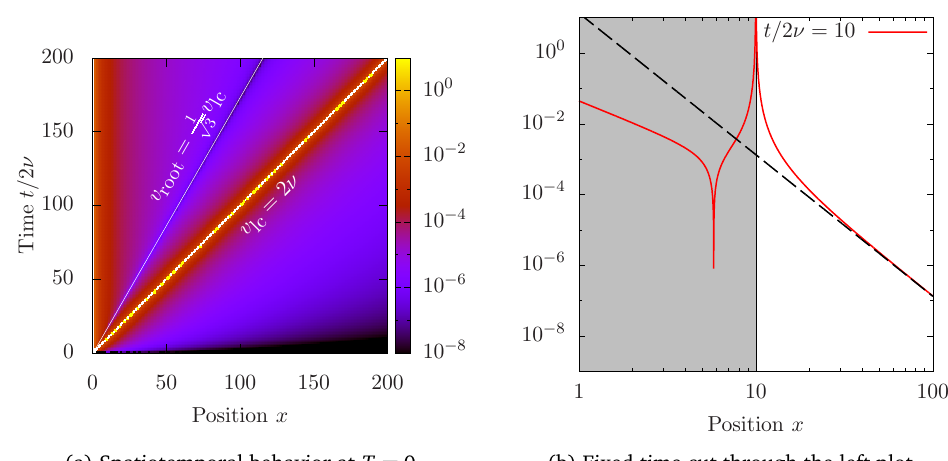
Figure 2: Spatiotemporal behavior of the equal-time anticommutator | C + ( x , t ) | at T = 0 ( β = ∞ ) without the initial correlations (as given in Eq. (29)). The signal on the diagonal is the light cone with an algebraic (power-law-like) decay. A horizontal cut through the plot for time t / 2 ν = 10 is shown on the right (Fig. 2b) with the algebraic decay of Eq. (30) indicated by the black dashed line. The grey shaded area marks the inside of the light cone with a stationary algebraic correlation decay starting at x = 0. Due to different signs this contribution cancels the inner decay coming from the light cone leading to an inner structure with vanishing correlation (cid:112) = t / ( 2 ν at x 3 ) root